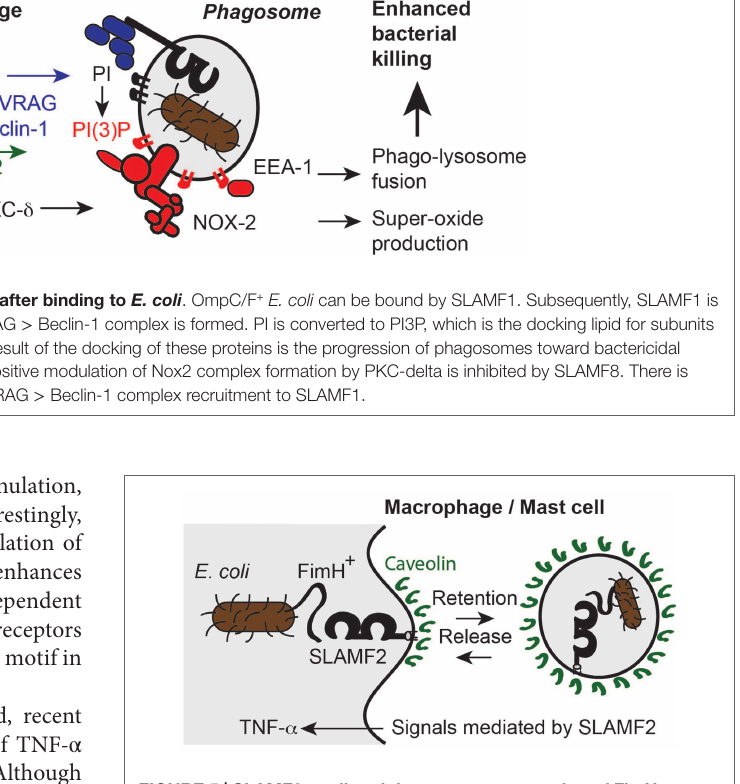
FiGURe 5 | SLAMF2 mediated the temporary retention of FimH + E. coli in phagocytes . SLAMF2 can associate with the bacterial lectin FimH on the flagella of E. coli . The bacteria are internalized into caveolin + vesicles to subsequently be released. The presence of SLAMF2 on macrophages and mast cells induced an LPS- or bacteria-mediated enhanced burst of TNF- α production.